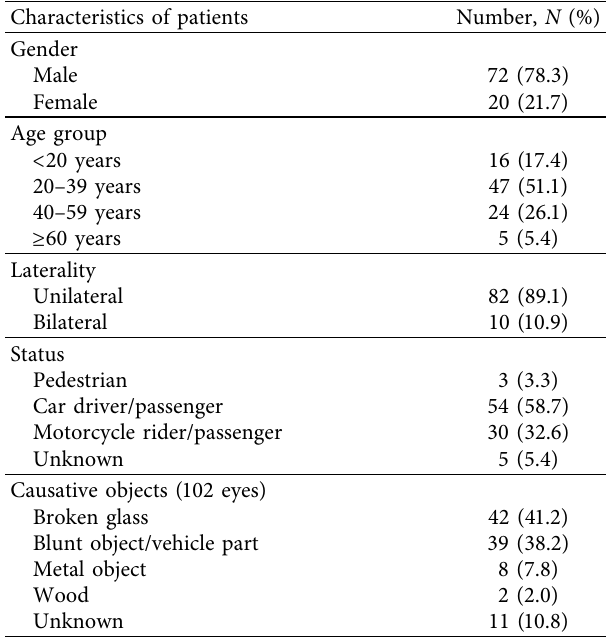
Table 1: Demographics of road traffic-related open globe injury